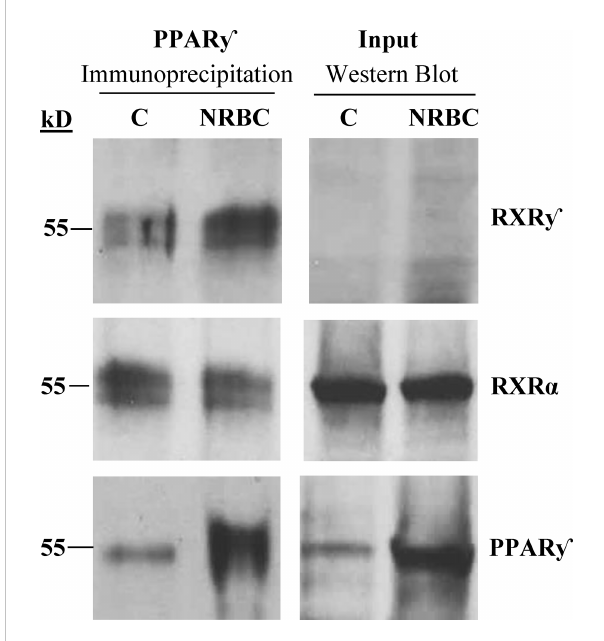
FIGURE 8 Analysis of RXR isoforms bound to immunoprecipitated PPAR g complexes. Adipocytes were treated with vehicle or NRBC for seven days. RXR g , RXR a and PPAR g protein levels were analyzed by Western blotting. For analysis of whole cell protein levels (input), 50 m g of protein lysate was loaded in each lane. PPAR g was immunoprecipitated from 600 m g of the same whole cell lysate for analysis of PPAR g cofactor binding. An anti-IgG k light chain secondary antibody was used for detection. This experiment was repeated three times with adipocytes from obese